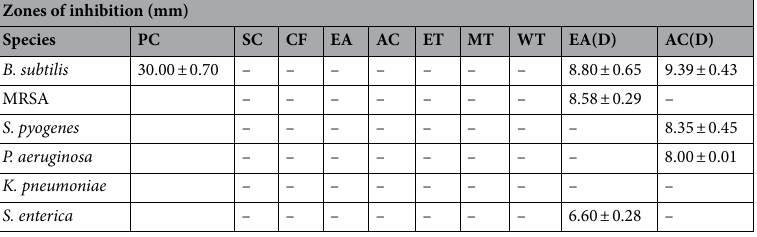
Table 1. Antibacterial activity of the N. lappaceum sequential and direct crude extracts via disc diffusion. “–” no activity, PC: positive control (Gentamicin 10 µg), SC: solvent control (DMSO < 1%), CF: chloroform, EA: ethyl acetate, AC: acetone, ET: ethanol, MT: methanol, WT: water, all these are sequential. EA(D): ethyl acetate direct; AC(D): acetone direct. The data is expressed as the mean ± standard error of two independent experiments performed in technical